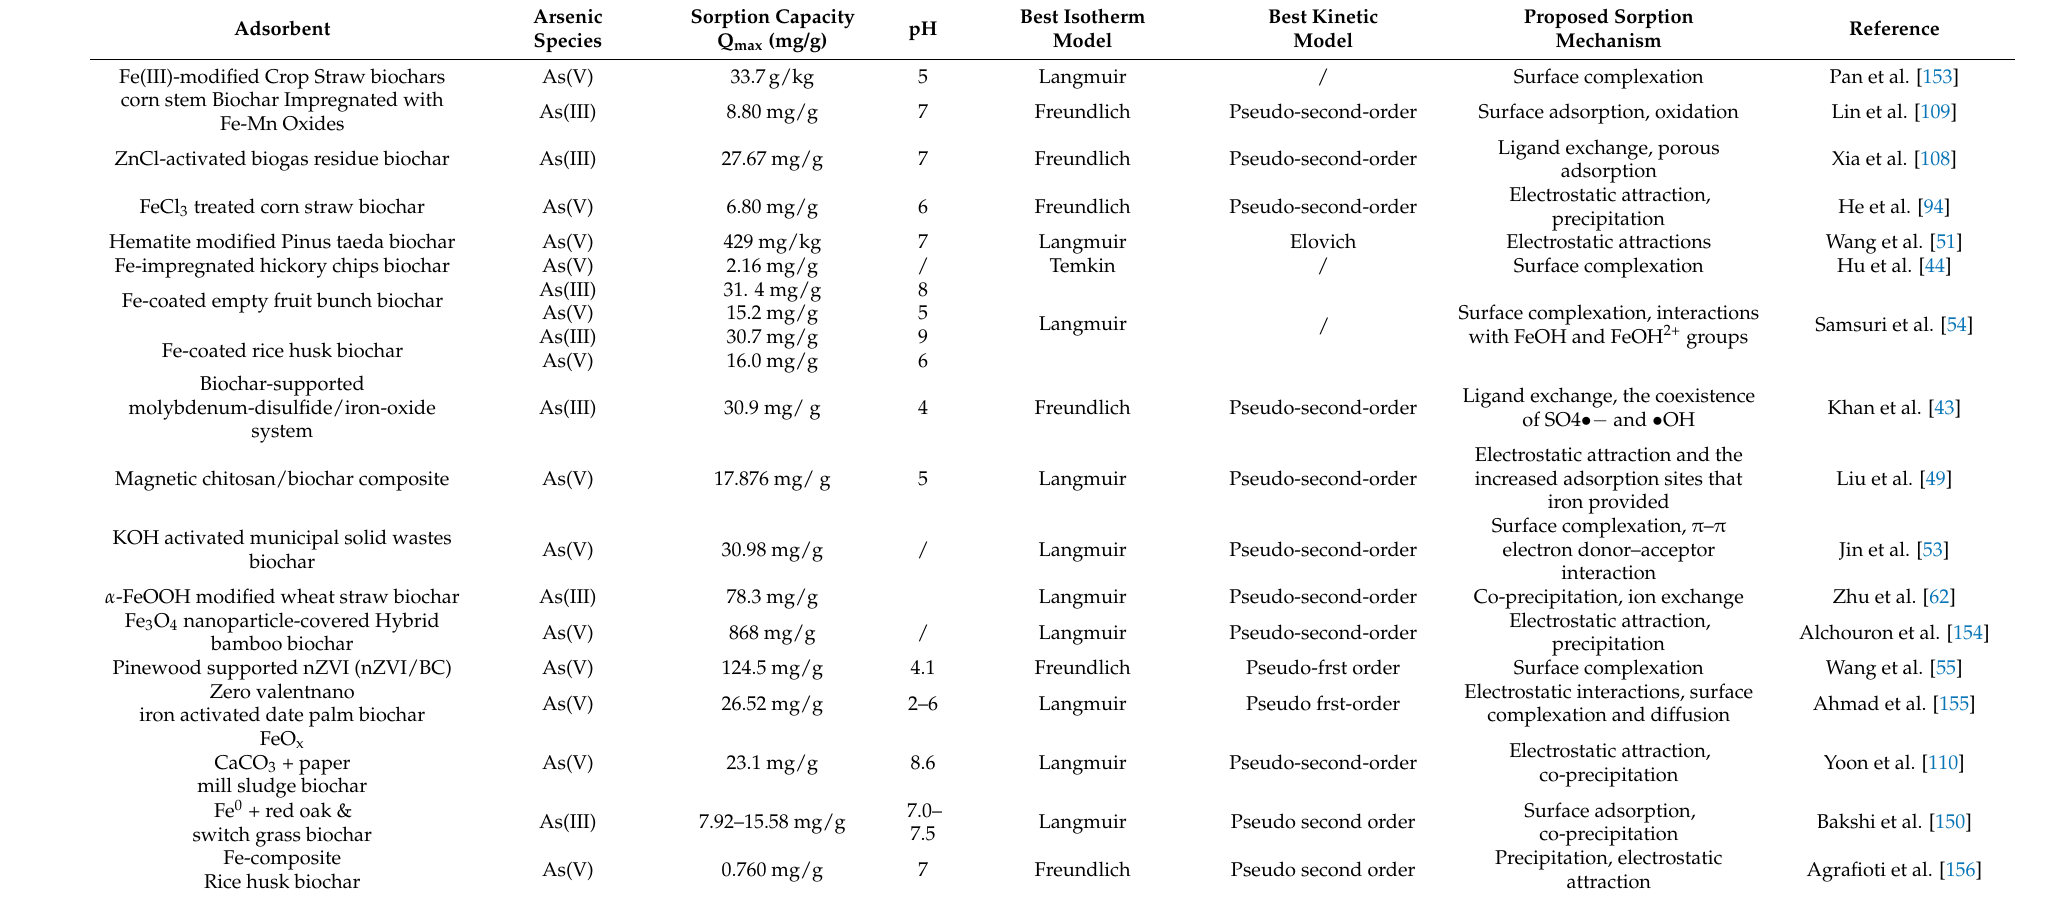
Table 3. Modified biochar adsorbents mechanism for arsenic removal from